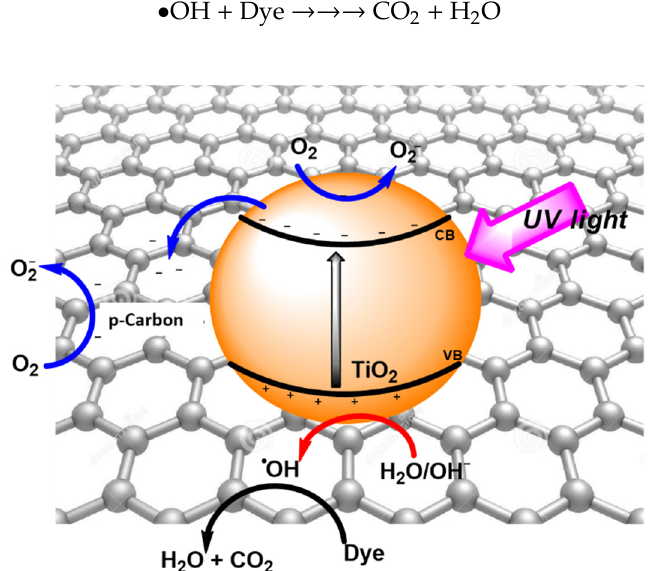
/ TiO 2 photocatalyst on